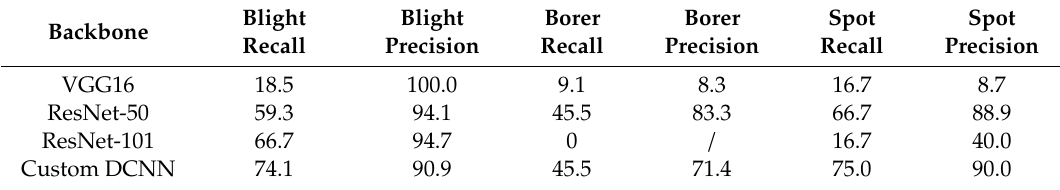
Table 8. Video metrics results of backbones from scratch using Video 1 (%) 1 .